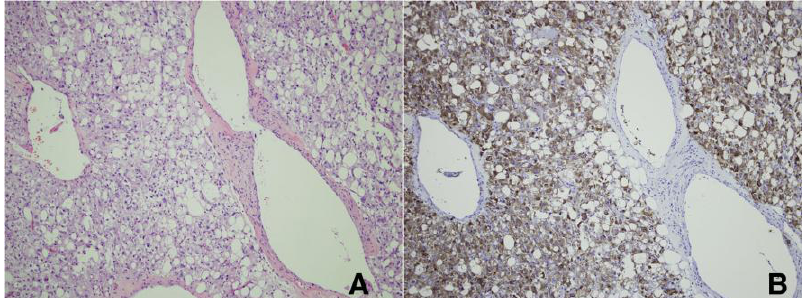
FIGURE 4. Microscopic image of AML with predominantly epithelioid morphology (A) with positive staining for HMB-45